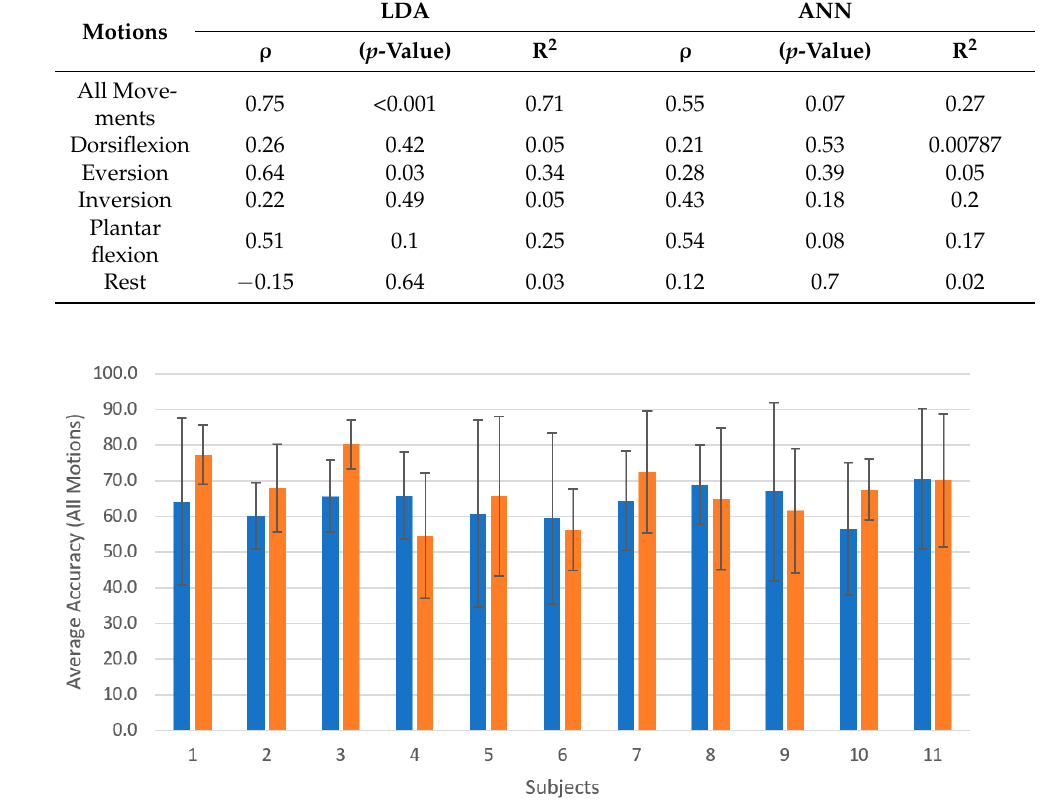
Figure 4. The average classification accuracy for all motion classes across all participants. The re ‐ sults are reported as mean ± standard deviation and asterisk denotes significant differences be ‐ tween motion class for each classifier. The asterisk denotes statistically significant difference.